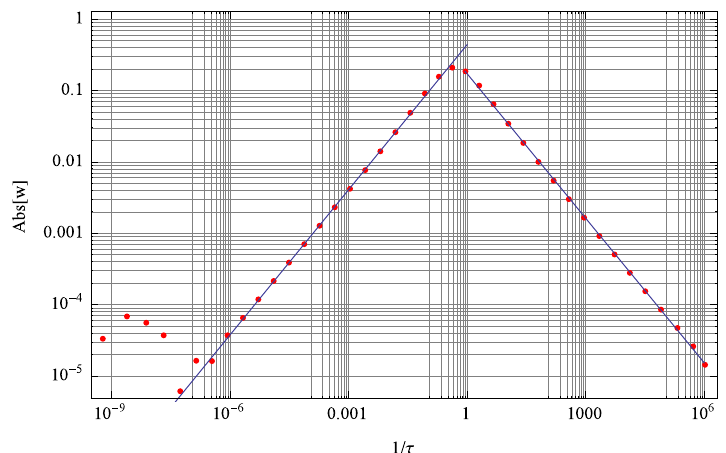
Figure 10. Scaling regions of the weights w 40 exponential functions and parameter values u